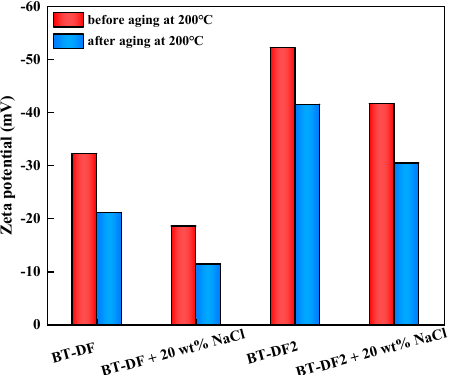
Figure 8. Zeta potential of different BT-DF (before and after aging at 200 °C).